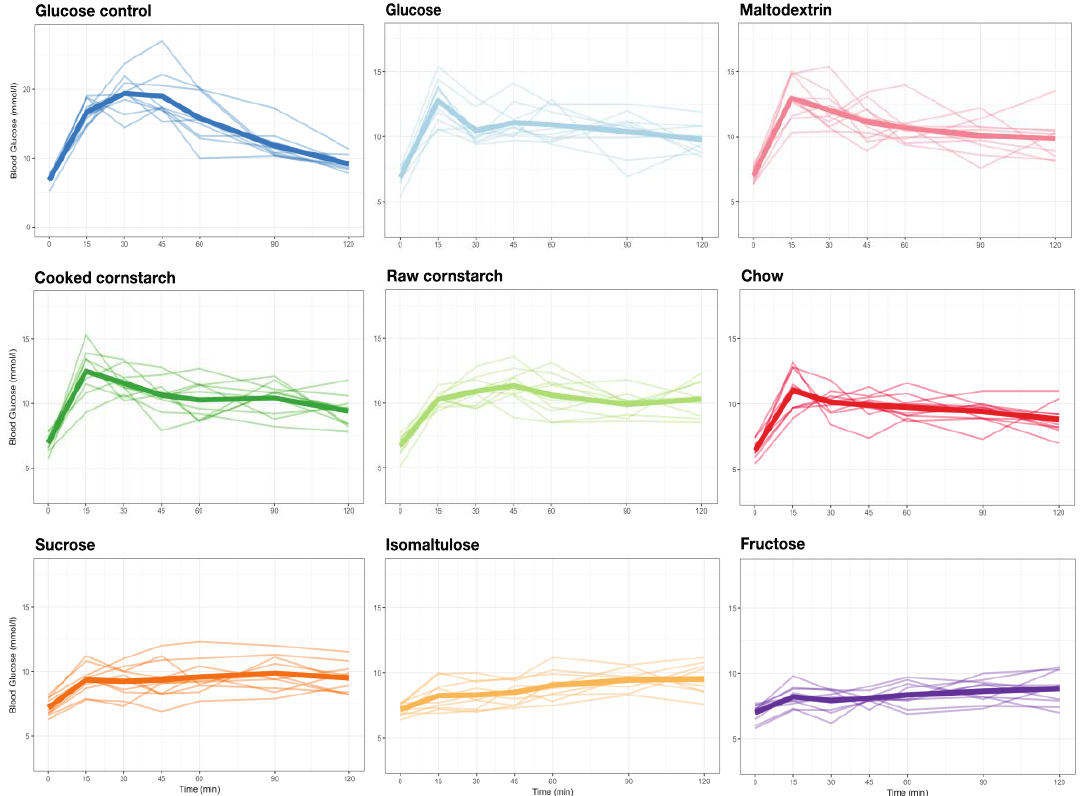
Figure 3. Line graphs of individual mouse blood glucose response to eight diets (containing 0.3 g carbohydrate) and glucose control (0.31 g) over two hours. n = 10 female mice for each diet.